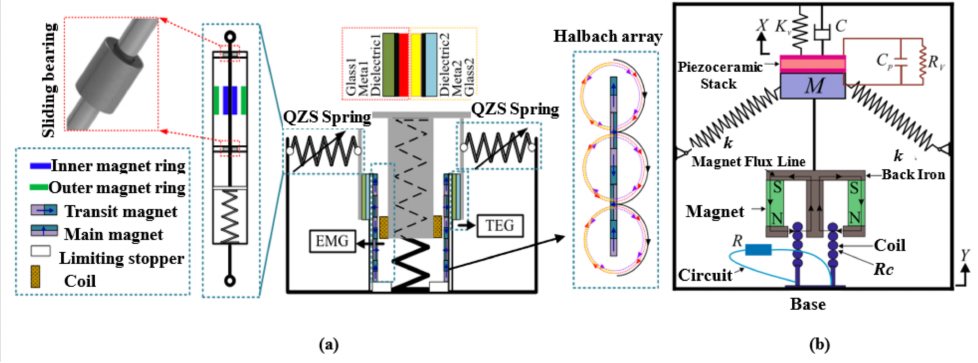
Figure 14. Typical structures based on hybrid QZS-SVIEH in ( a ) Multi directional composite QZS energy harvesting structure and ( b ) Hybrid energy harvesting structure. Reprinted/adapted